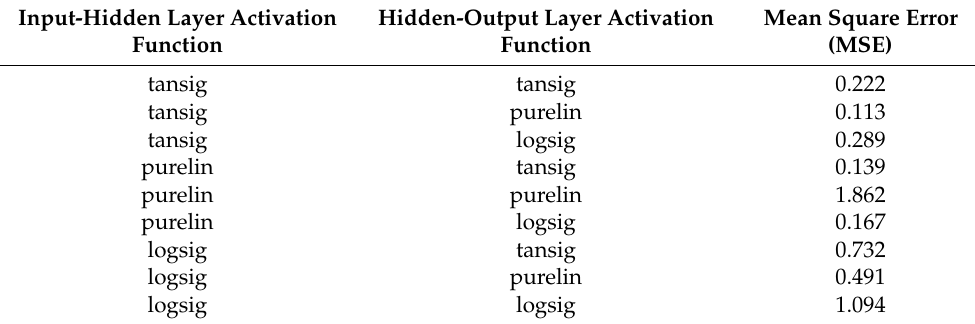
Table 3. Performance of different activation function